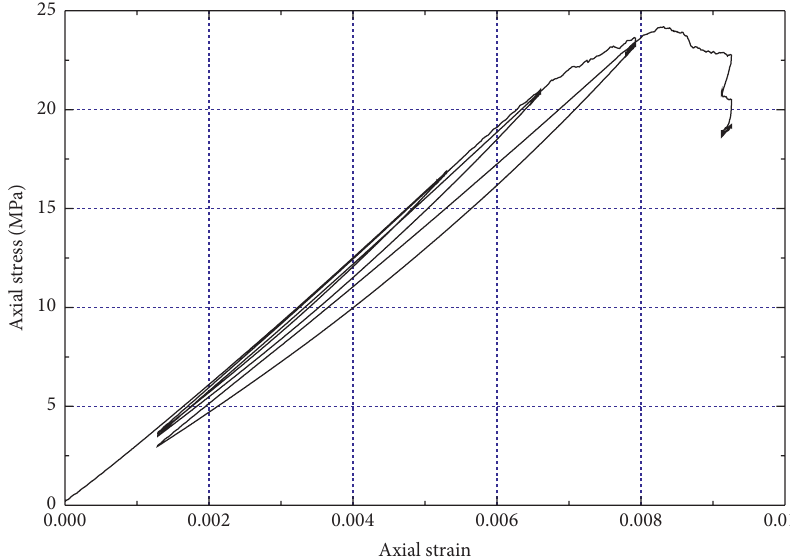
Figure 11: Stress-strain curve of numerical The E Figure 15. During the first two stages of cyclic loading, E , E − , and Y values did not show the fluctuation + + phenomenon in the experimental process at the early stage remained basically unchanged. The indicator E − tends to of cyclic loading. The main reason may be the fluctuation of increase, but the change is not obvious, and it is always elastic modulus caused by the continuous opening and maintained around 3 GPa. The loading and unloading re- closing of cracks inside the sample with cyclic loading and sponse ratio Y fluctuate around 1. At the third cyclic loading unloading. The influence of the fissures is not considered in stage, E − suddenly increases to 4.07 GPa. While E decreases + the numerical simulation, so the elastic modulus does not to 2.96 GPa, and the Y value fluctuates. Finally, the specimen change much. In summary, the modulus of elasticity E was damaged in the fourth cyclic step. The indicator E − E − and the response ratio Y of unloading and loading appear increased sharply to 9.78 GPa, while E suddenly decreased + to a negative value. Subsequently, the response ratio Y also to change more obviously when the sample is close to fluctuates, which is consistent with the experimental results. damage, so it can be used as a basis for damage precursors.